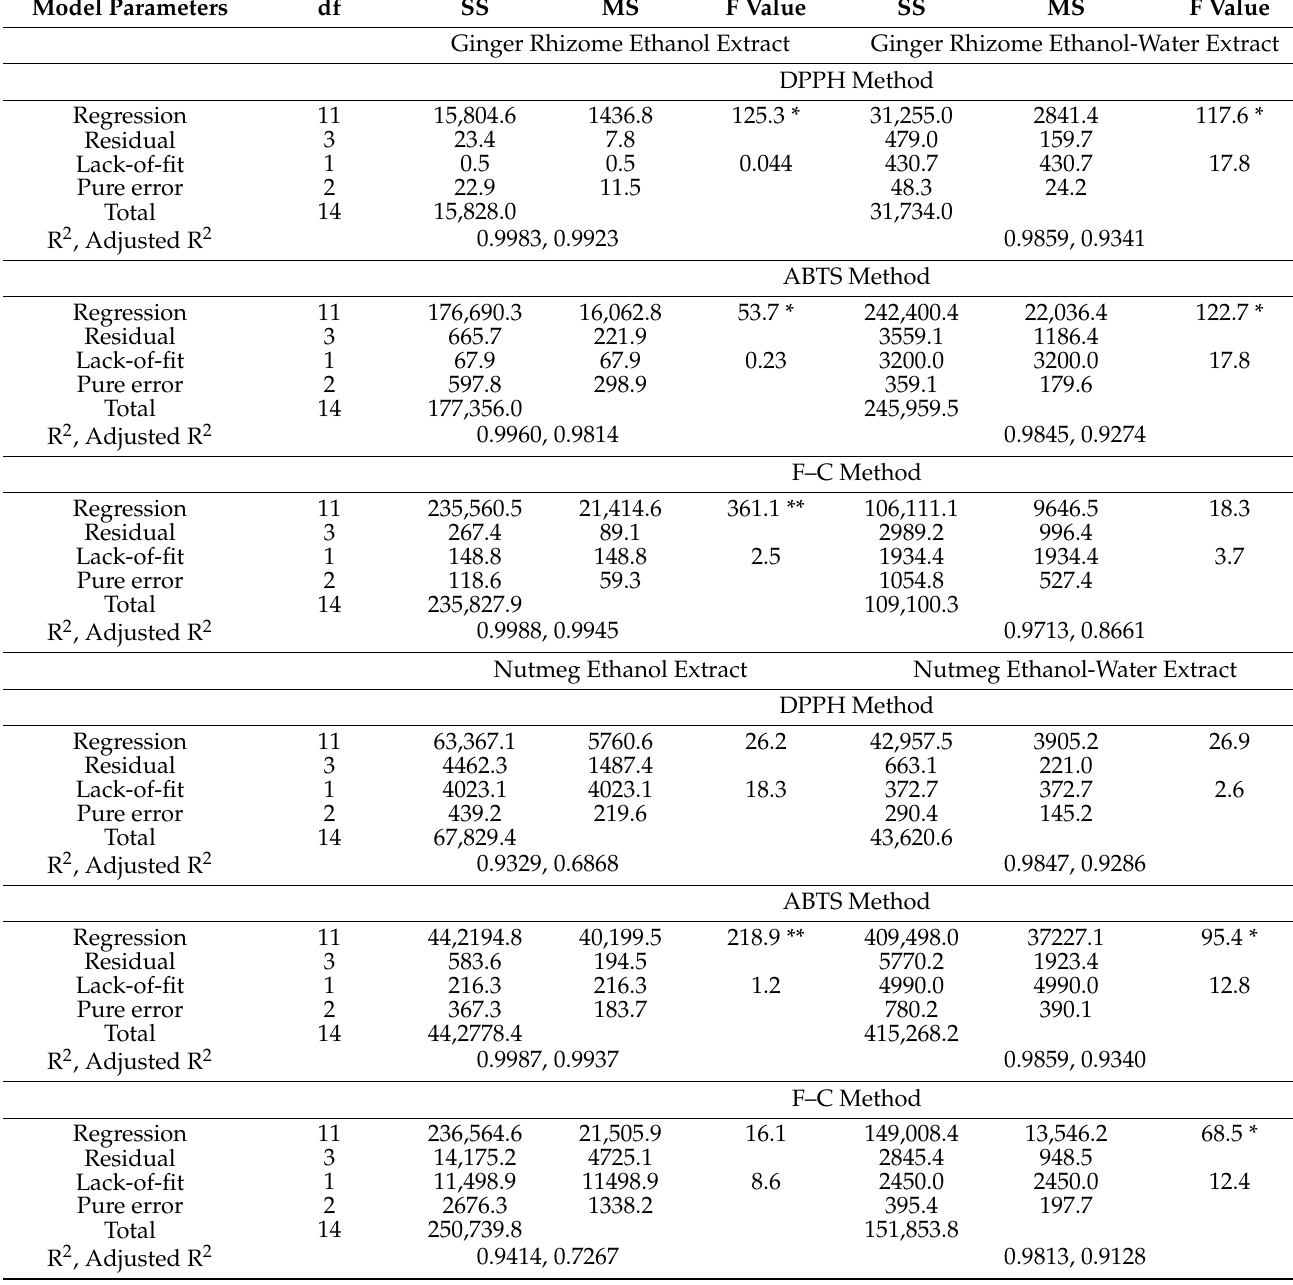
Table 4. Analysis of variance (ANOVA) results for the responses: antioxidant properties of ginger rhizome and nutmeg extracts determined by DPPH, ABTS, and F–C